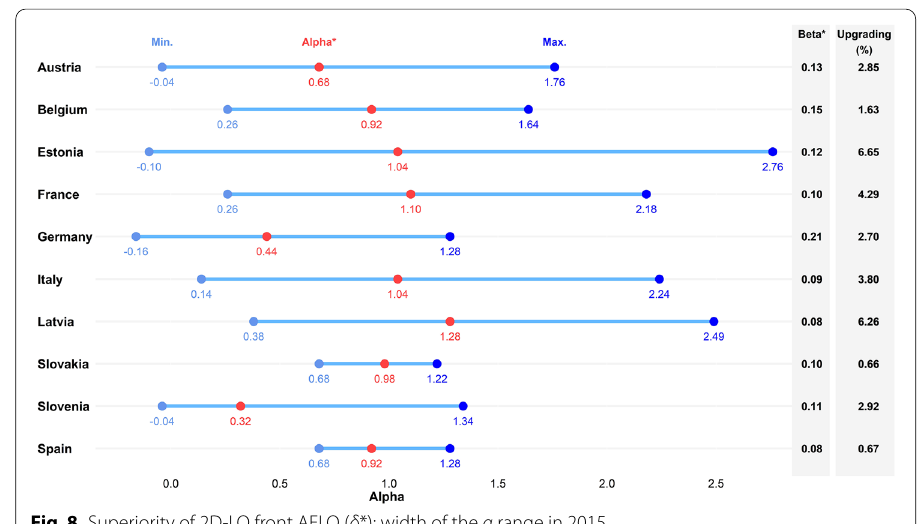
Fig. 8 Superiority of 2D‑LQ front AFLQ ( δ *): width of the α range in